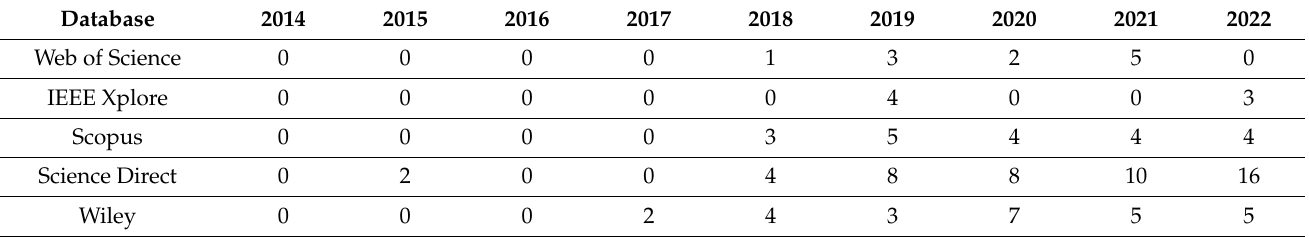
Table 3. Each database’s annual number of papers with “centralized/centralized ledgers” keywords.